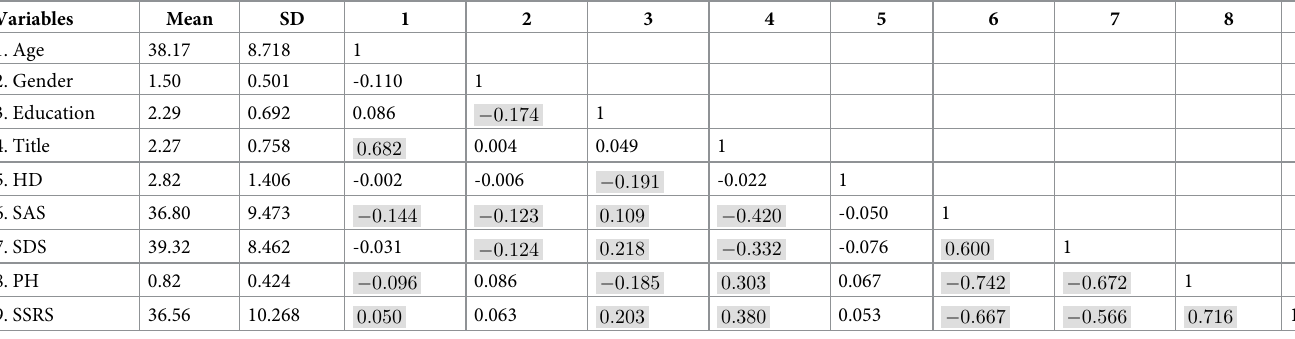
Table 2. Correlation matrix for the SSRS, SDS, SAS, PH, and demographic